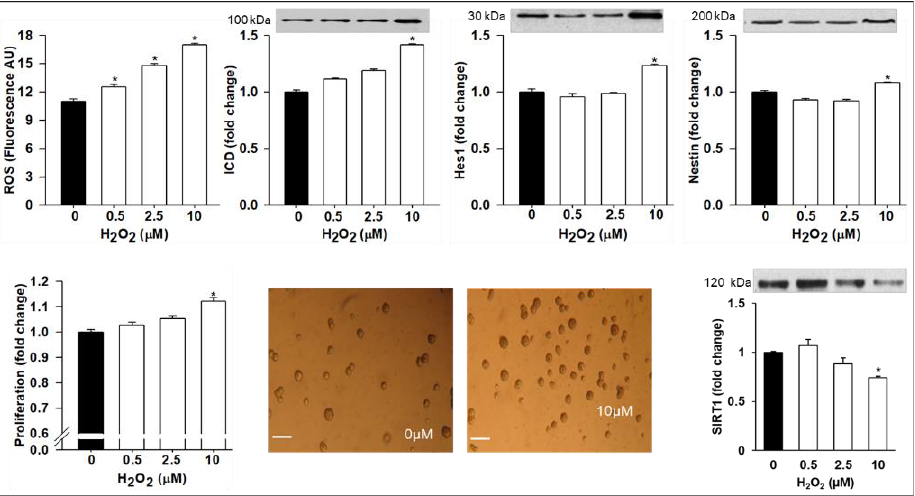
Figure 4. H 2 O 2 Promotes ROS Production and Upregulates NPC Notch/Hes1 Pathway and NPC Proliferation with Downregulation of SIRT1. Hypothalamic NPCs were treated with various doses (0.5, 2.5, and 10 µM) of H 2 O 2 in complete medium for 24 h. Values are (Mean ± SEM of n = 4 inde- pendent experiments with each treatment performed in duplicate) normalized to untreated control cells and expressed as fold change. For protein expression, representative immunoblots are shown.